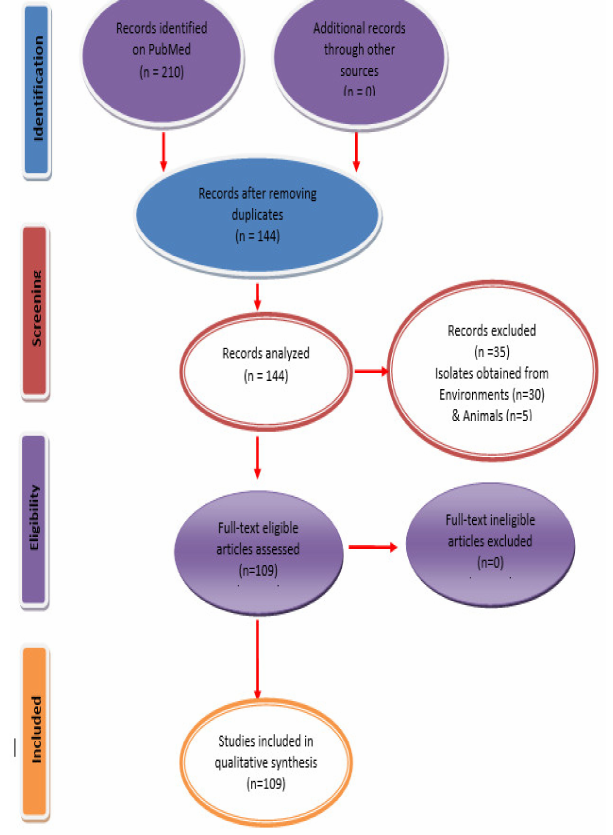
Figure 1. PRISMA flow diagram for study inclusion. PRISMA = preferred reporting items for systematic reviews and